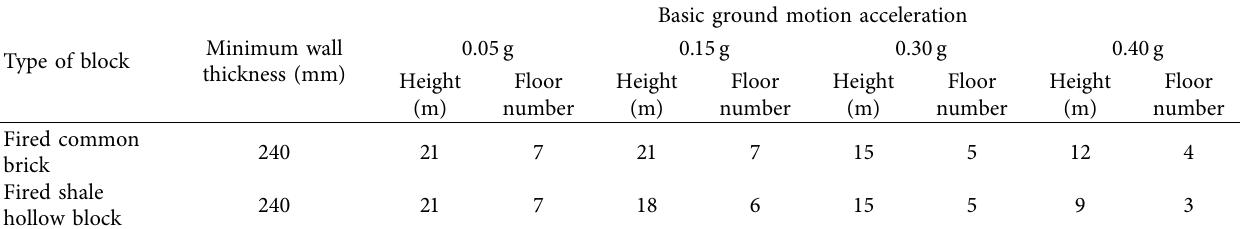
Table 4: Floor number and height limit of masonry structures.